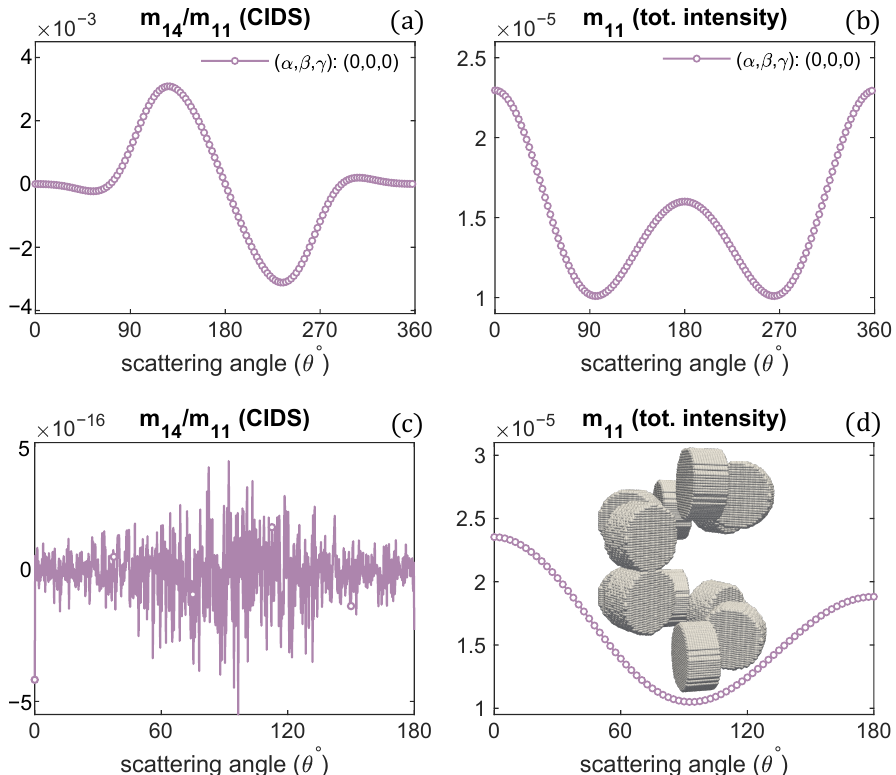
Figure 6. CIDS and total scattered intensity for the helical fiber as shown in the inset of ( d ): 1-turn of left-handed fiber on a 1-turn right-handed helical fiber; ( a , b ) at a fixed orientation, ( c , d ) in the fixed